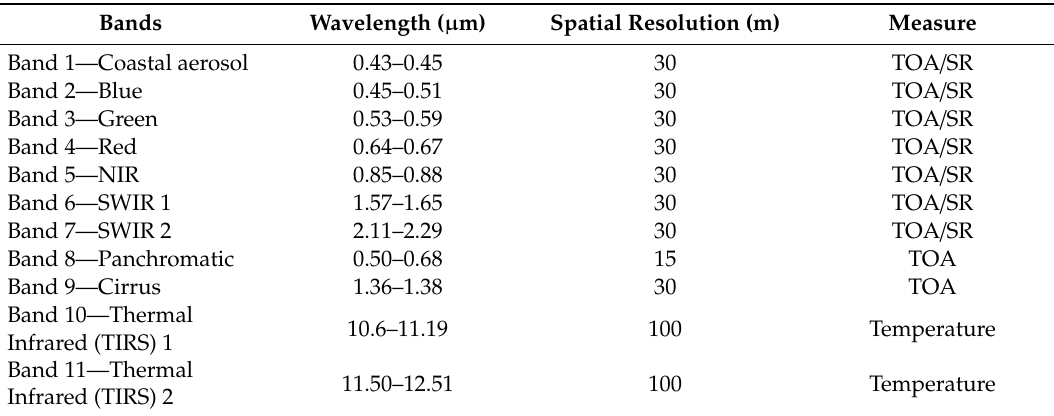
Table 1. LANDSAT 8 (cid:48) s OLI and TIRS instrument